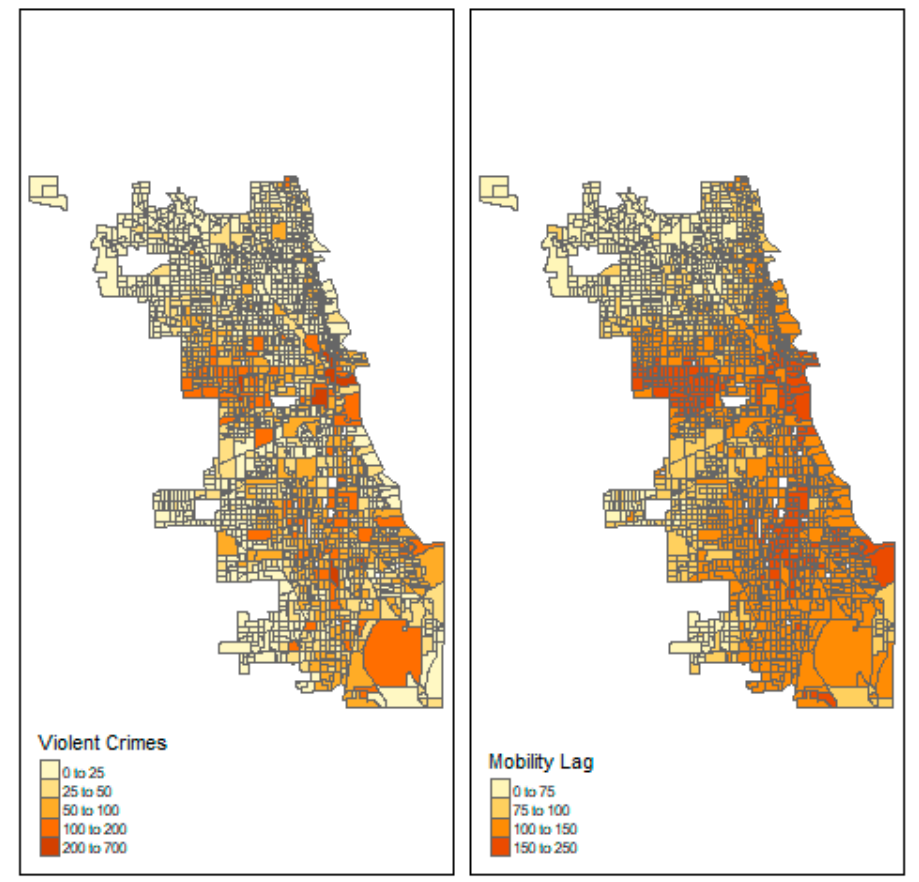
Figure 1. Chicago Violent Crimes and Mobility Lag. To operationalize spatial lag, I look at the census block groups that are contiguous with a given census block group. This approach aligns with past research [8]. Subsequently, I specifically operationalize spatial lag as the proportion of contiguous tracts that experi- enced a violent crime in the previous hour. As an example, if a given neighborhood was contiguous with five other neighborhoods and exactly one of them experienced a